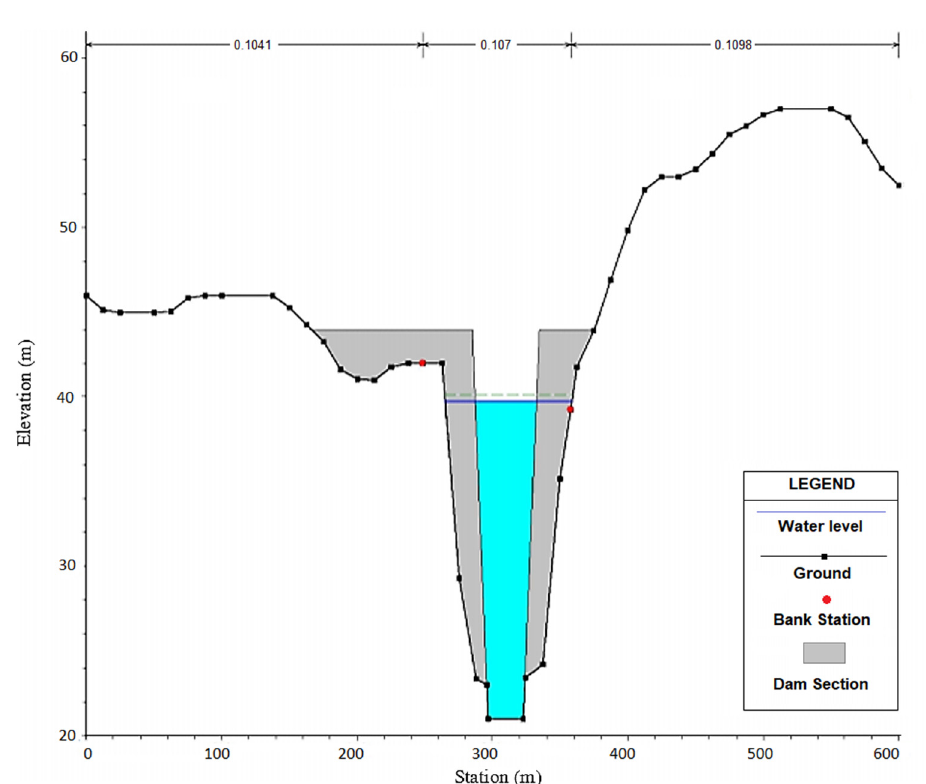
Figure 7. Failure scenario A at T = 1.03 h.